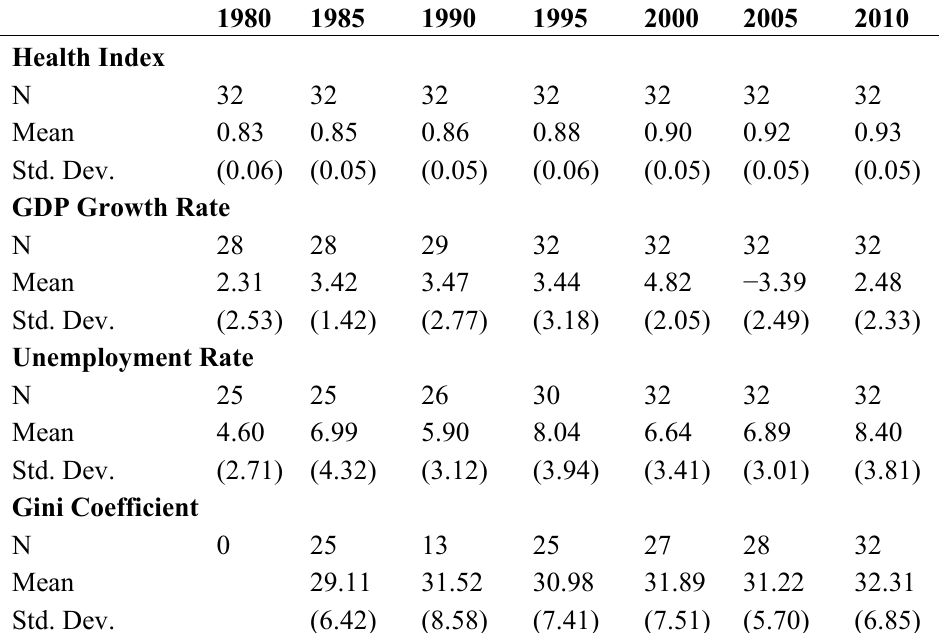
Table 1. Descriptive statistics for the main study